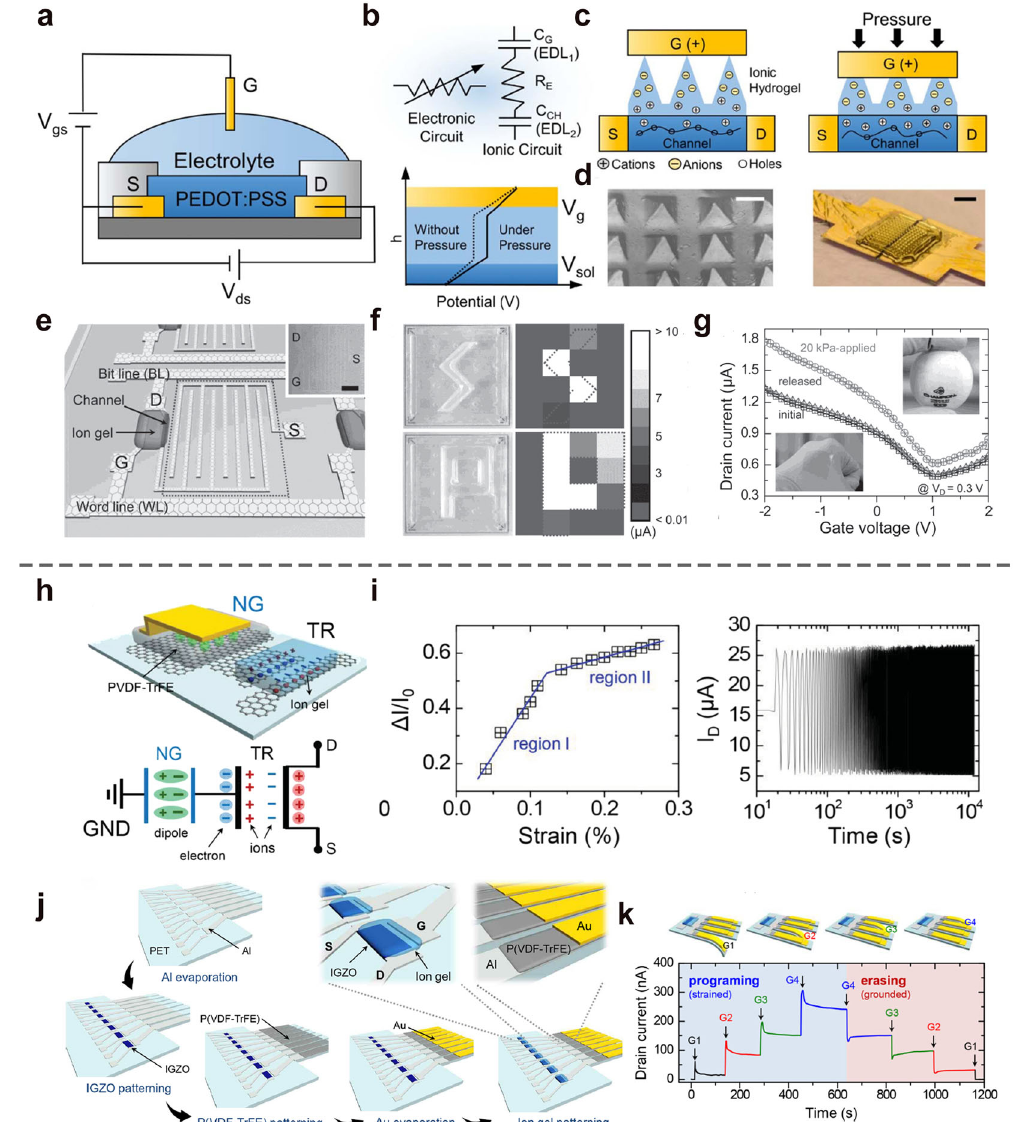
Fig. 5 Piezo electronics sensor made of ionic-gel transistor. a Schematic diagram of the device structure of an OECT. b quivalent circuits in an OECT and schematic diagram of the proposed microstructured hydrogel-gated OECT iontronic pressure sensor. The deformation of the hydrogel determines the number of ions delivered into the channel. c ) V g and V sol change after application of external pressure on the gate electrode. d SEM image of gelatin methacryloyl (GelMA) hydrogel with pyramidical microstructures on the surface; Lower picture is a real optical image of the OECT iontronic pressure sensor. Reproduced with permission 84 . Copyright 2021, IEEE. e Schematic diagram of a GFET pressure sensor fabricated with interdigitated source electrodes. f Spatial pressure graph of GFET pressure sensor matrix. g Pressure sensing characteristics of GFET pressure sensor mounted on PDMS rubber substrate. The illustration shows the GFET matrix making angular contact with human hands or table tennis. Reproduced with permission 83 . Copyright 2014, Wiley-VCH. h Mechanism of GT strain sensing based on piezoelectric potential gating. i Sensitivity and stability characteristics of piezoelectric gated GT strain sensor. Reproduced with permission 58 . Copyright 2015, Wiley-VCH. g Process for manufacturing multi-level non-volatile memory array for piezoelectric potential programming. k Real-time programming and erasing steps applied to piezoelectric potential programming memory. Reproduced with permission 93 . Copyright 2016, American Chemical prompting researchers to turn to other methods. The piezoelectric Ionic-gel electrolyte materials are extensively applied in piezo- effect is de fi ned as the electric polarization of the piezoelectric tronic transistors owing to their large capacitance that enables material that originates from materials that lack inversion low-voltage transistor operation 91,92 . The long-range polarization symmetry, caused by the action of external mechanical forces; characteristics of ions in the ionic gel allow the placement of the piezoelectric materials convert random mechanical energy into gate electrode and channel to be coplanar. Sun et al. 58 described a electric energy (piezopotential power) 85,86 . The piezotronic piezopotential-powered active strain sensor matrix array combin- ing piezoelectric nanogenerators (PENGs) and coplanar-gate transistor, utilizing inner-crystal piezopotential to harvests bio- graphene transistors based on P(VDF-TrFE), as shown in Fig. 5h. chemical and biomechanical energy 87,88 , while achieving self- The output pressure sensor signal is maintained at the corre- powered active digital data processing capacities, such as pressure sponding value based on the applied strain. The ionic-gel arrays with high resolution and human-machine interaction 89,90 .